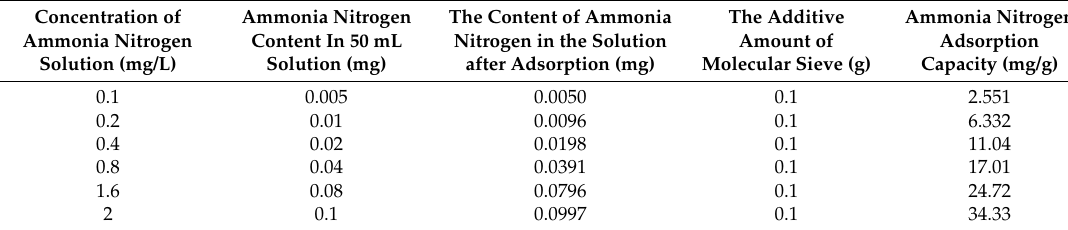
Table 3. Removal of ammonia nitrogen from H-SBA-15-SH molecular sieve.